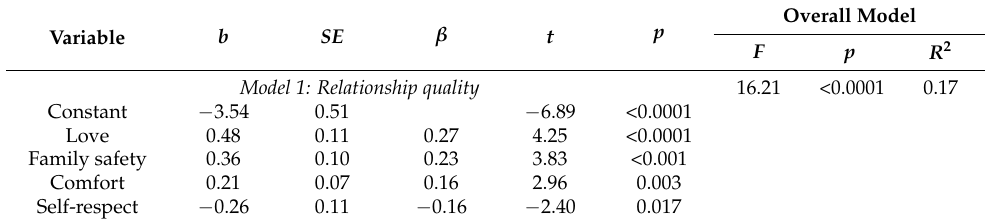
Table 6. Multiple linear regression analysis of the relationship